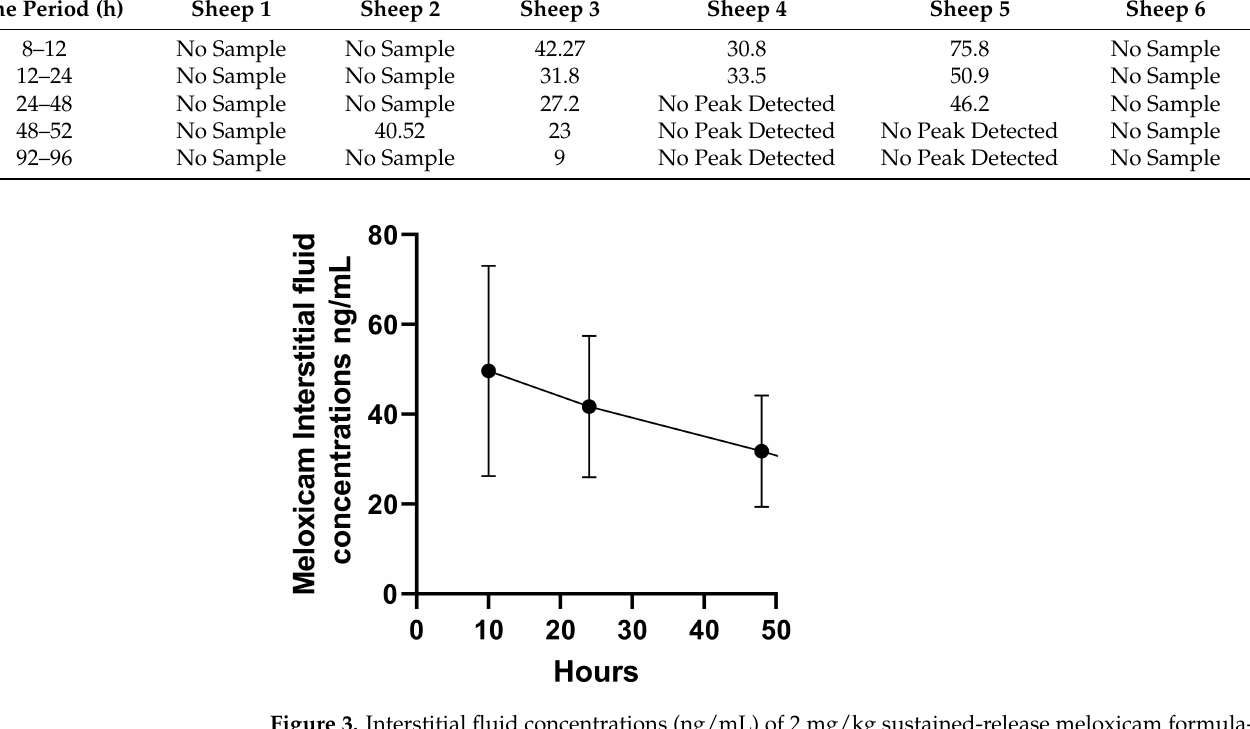
Figure 3. Interstitial fluid concentrations (ng/mL) of 2 mg/kg sustained-release meloxicam formula- tion (SRMF) following subcutaneous administration in sheep ( n =